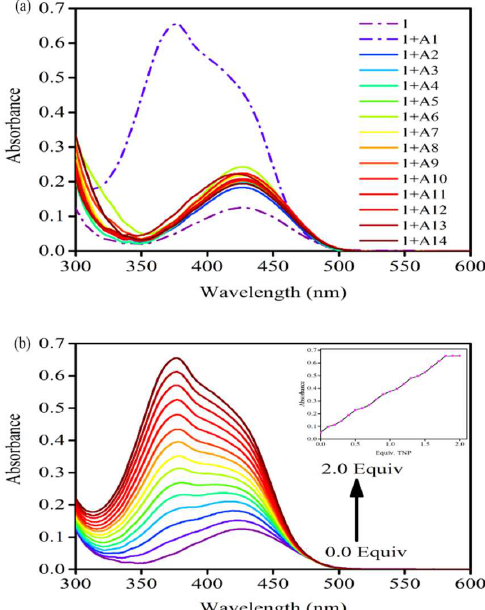
Figure 2. ( a ) UV-vis absorption spectra of receptor 1 in the presence of 2 equivalents of various nitroaromatics ( A1 – A14 ) in acetonitrile; and ( b ) UV-vis titration experiment of 1 in the presence of TNP.